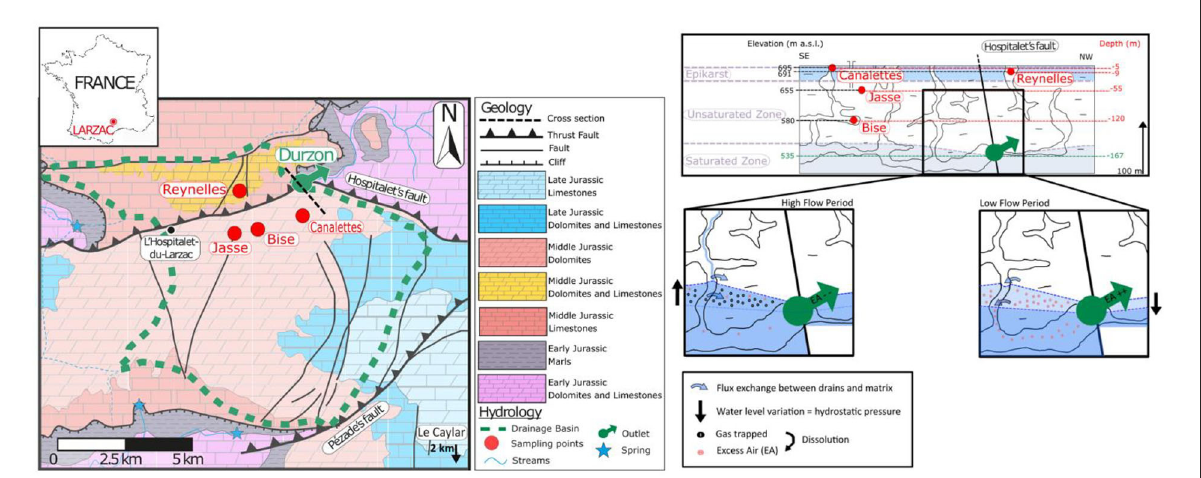
FIGURE1 (Left) Geological map of the Durzon karst system (modified from Fores, 2016) (Right) Schematic cross-section made from the Durzon spring with a projection of the different sampled points along the non-saturated zone with a hypothetical position of the water level of the saturated zone (modified from Pérotin et al.,